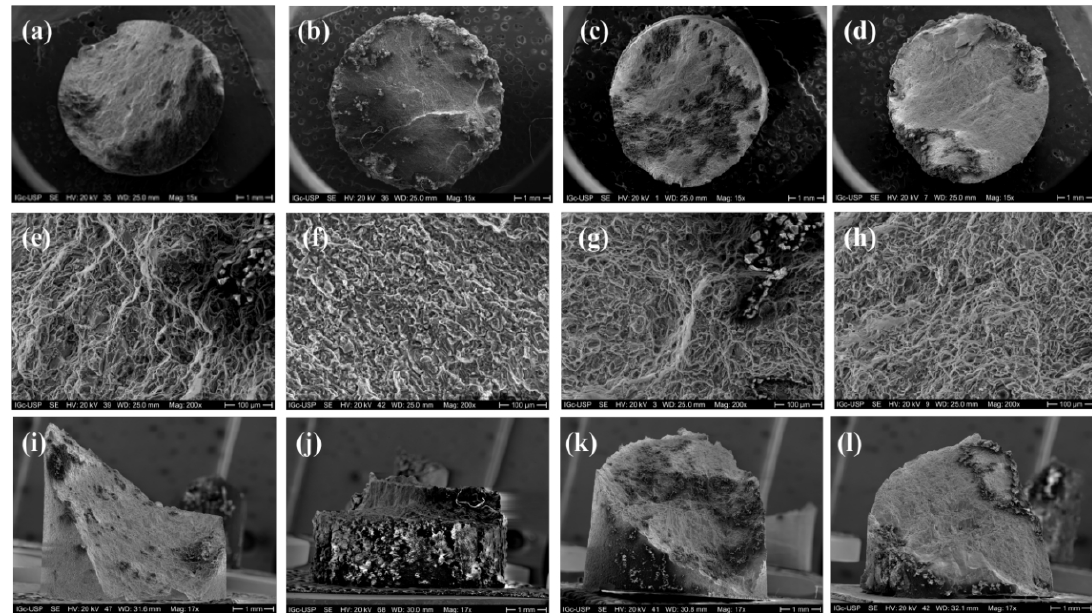
Figure 13. SE-SEM micrographs of the fracture surfaces of the SI-20 and SI-30 samples: a) SI-20 cross-section; specimen tested in air; b) SI-20 cross section; specimen tested in 0.1 M NaCl solution; c) SI-30 cross-section; specimen tested in air; d) SI-30 cross section; specimen tested in 0.1 M NaCl solution; e) high magnification view of (a); f) high magnification view of (b); g) high magnification view of (c); h) high magnification view of (d); i) SI-20 side view; specimen tested in air; j) SI-20 side view; specimen tested in 0.1 M NaCl; k) SI-30 side view; specimen tested in air; j) SI-30 side view; specimen tested in 0.1 M